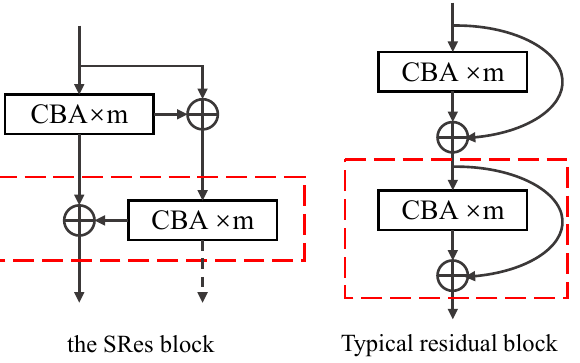
Figure 2. Proposed SRes block and typical residual block. CBA = convolutional layer + batch normalization + activation